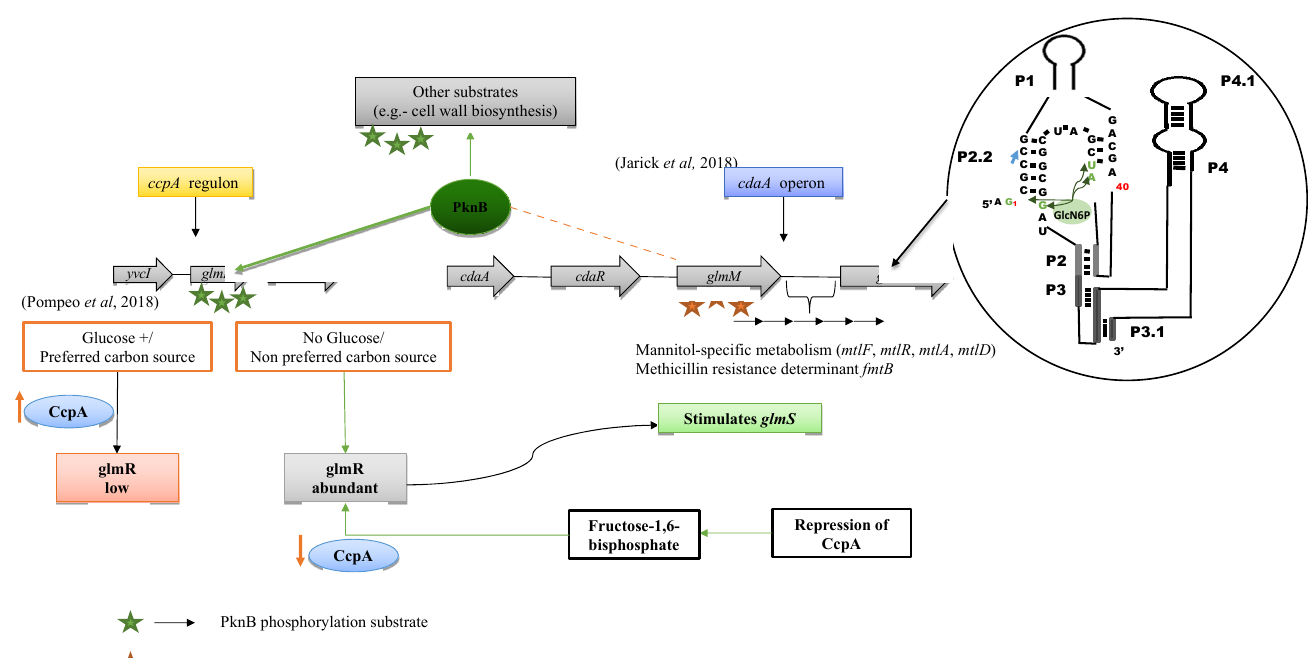
Figure 5. Cell wall metabolism regulated by pknB , the cdaA operon and the ccpA regulon. The different effects in the presence and absence of the preferred carbon source are given. The red stars indicate the direct phosphorylation of GlmM (phosphoproteome analysis and phylogenetic conservation; see [16]). The central molecule PknB (green) regulates GlmR by direct phosphorylation as well as cell wall biosynthesis components (green asterisks). GlmR is a part of the ccpA regulon (see [16]), which upon activation by PknB is expressed, which in turn stimulates the expression of GlmS. GlmS is a part of the cdaA regulon. The cdaA regulon, as shown, has mannitol-specific enzymes and methicillin-resistant determinant FmtB protein conserved in S. aureus . These genes can play a vital role in virulence as Gram-positive bacteria have a thick peptidoglycan layer and both these regulons can affect the expression of cell-wall-associated pathways. The different effects in the presence and absence of the preferred carbon source are given. Upper-right circle: secondary structure of the catalytic domain of the glmS ribozyme in S. aureus . The arrowhead indicates the site of self-cleavage. The guanine at the cleavage site is considered the first residue (G1). Predicted secondary structure of the S. aureus glmS –riboswitch aptamer showing the three-junction stem–loop structure typical of the glmS riboswitch aptamer. Helices P1, P2, P2.2, P3, P3.1, P4 and P4.1 are highlighted, where P1 to P2 is a catalytic core of the glmS riboswitch. Bases interacting with GlcN6P are marked in green. Base-pairing notation is the same as that published previously for B. subtilis [17].